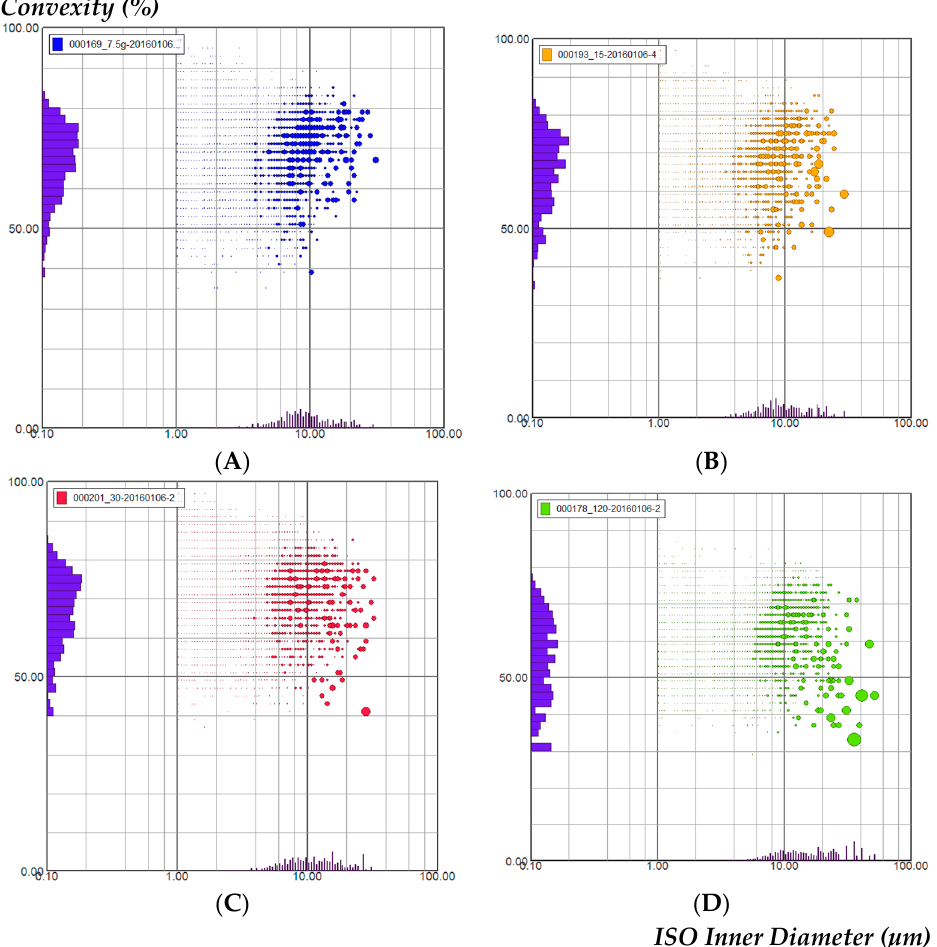
Figure 3. Analysis of the particle convexity and size of ( A ) G-1 decoction; ( B ) G-2 decoction; ( C ) G-3 decoction; ( D ) G-4 decoction.